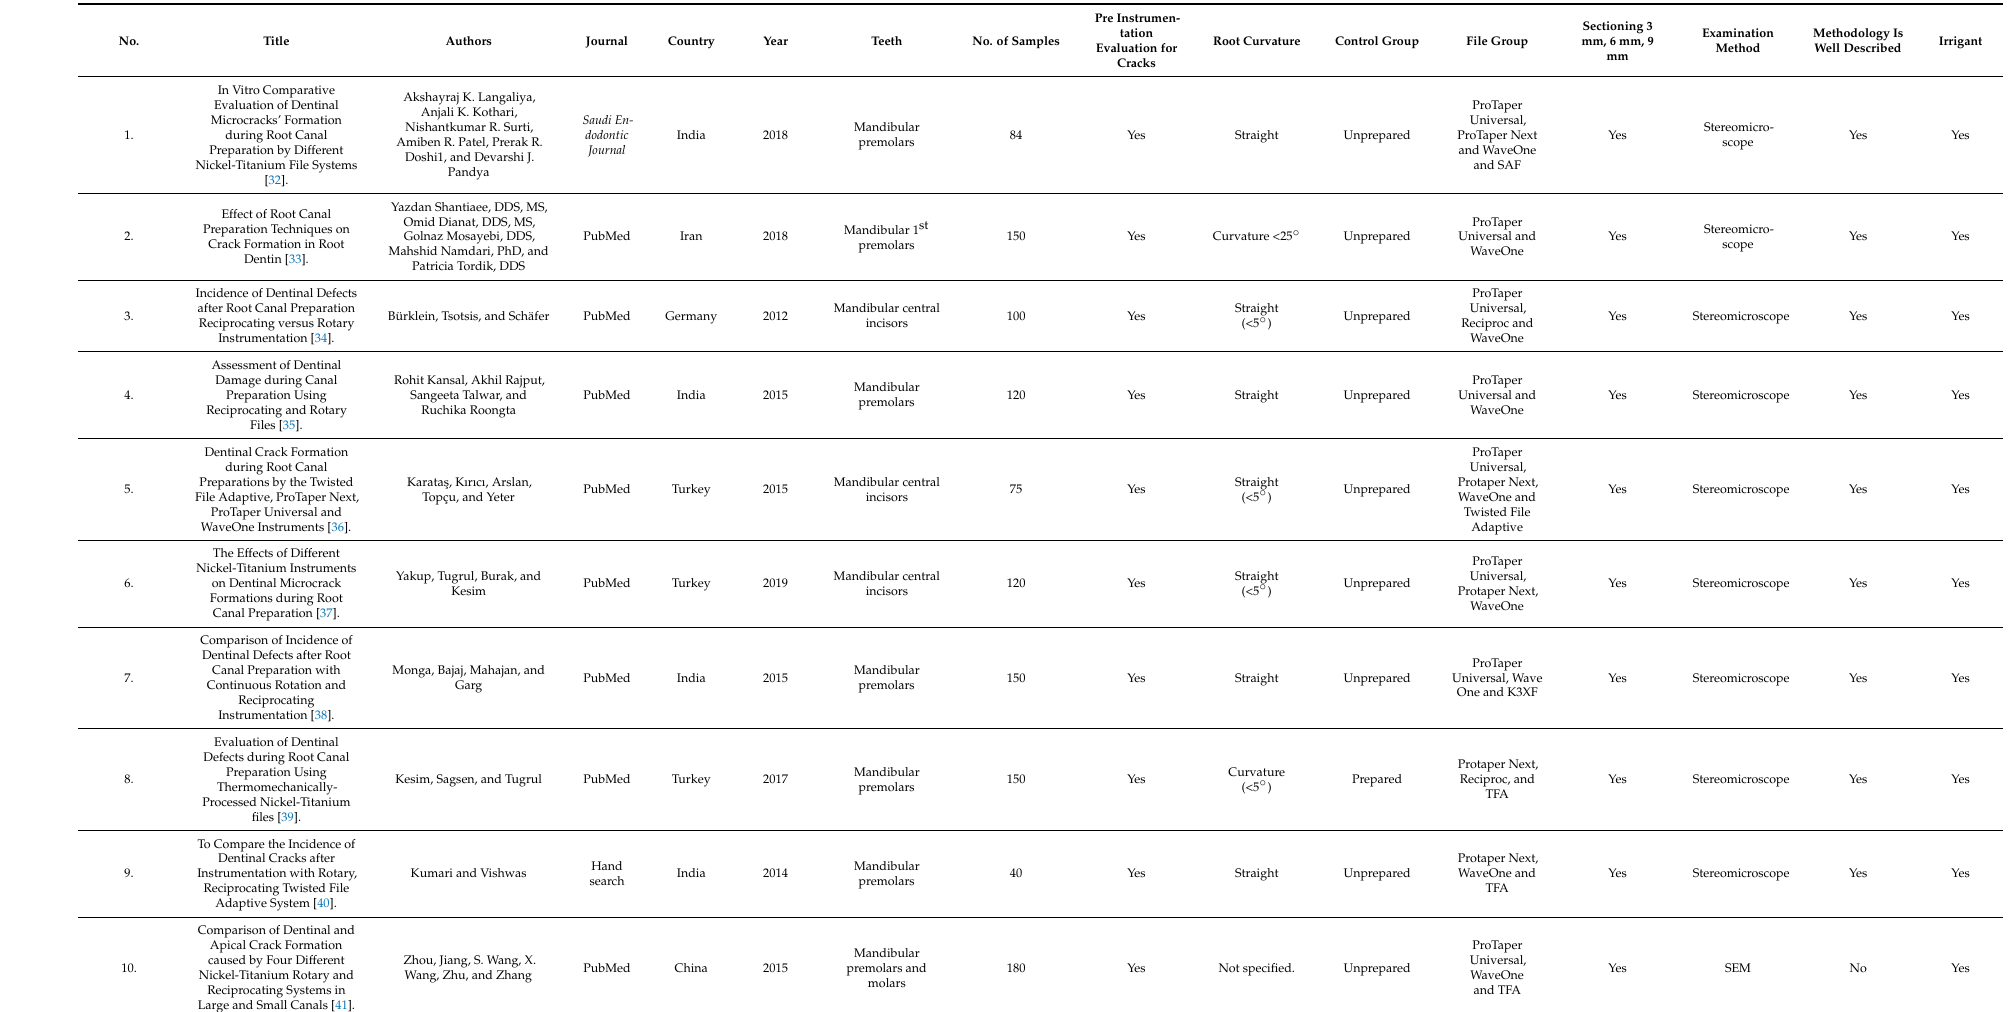
Table 4. Characteristics of the studies included in the systematic